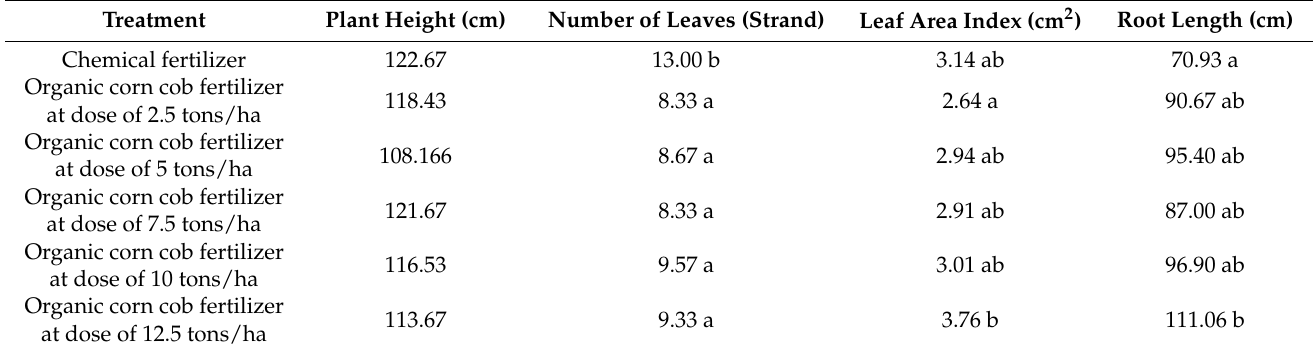
Table 2. The role of various doses of corn cob organic fertilizer on corn